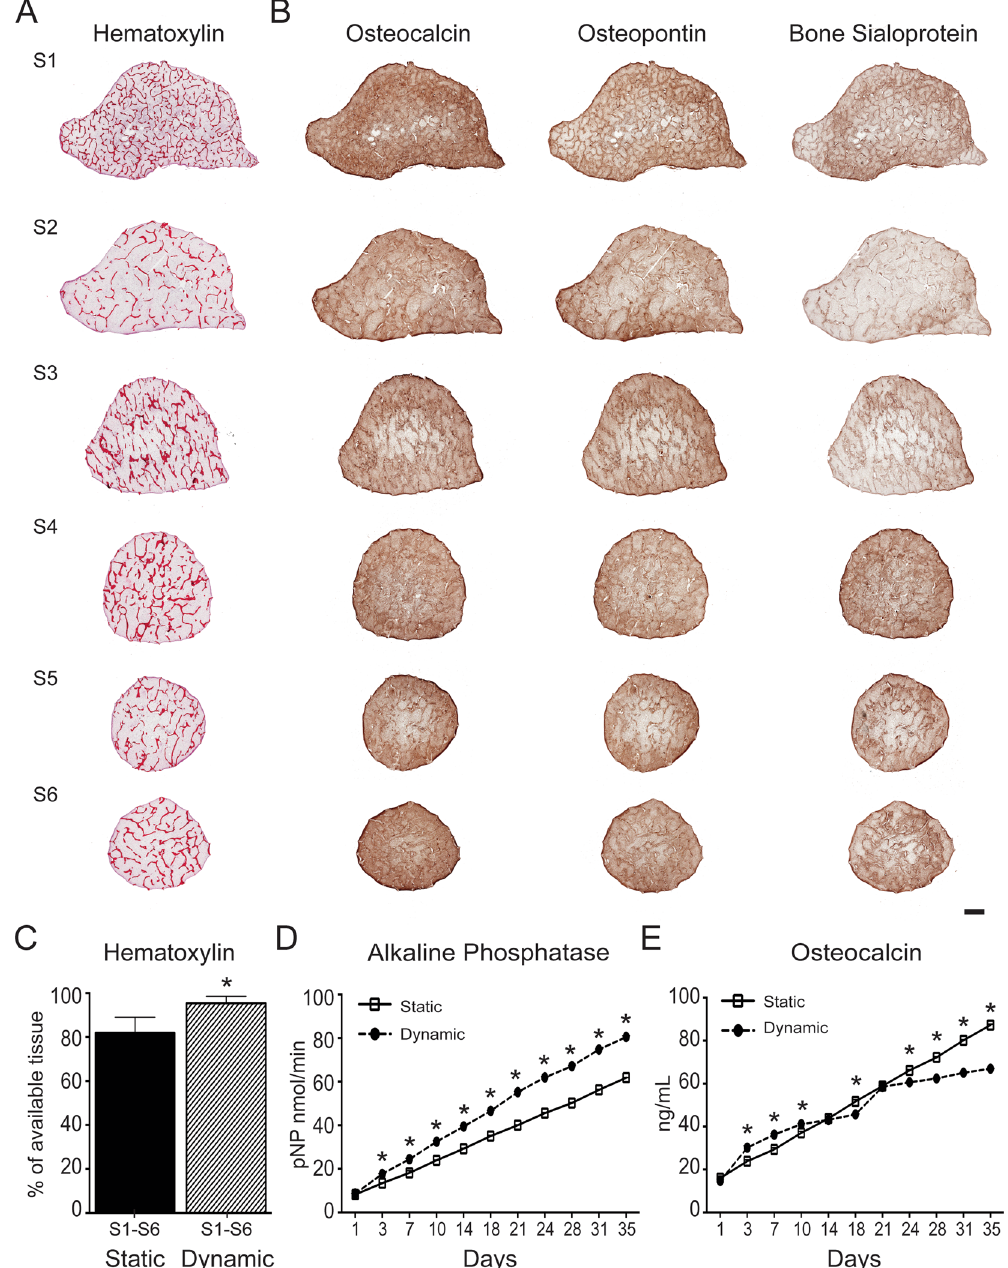
Figure 5. Tissue formation. ( A ) Histological analysis of samples corresponding to the six defect segments (S1-S6) cultured under dynamic conditions in bioreactors. Samples are stained with hematoxylin/eosin, which stains cell nuclei blue and extracellular matrix pink. Scale bar: 2 mm. ( B ) Immunohistochemical analysis of samples corresponding to the six defect segments (S1-S6) cultured under dynamic conditions in bioreactors. Samples stain positive (brown) for osteocalcin, osteopontin and bone sialoprotein. Scale: 2 mm. ( C ) Quantification of hematoxylin/eosin staining for samples corresponding to the six defect segments (S1-S6) cultured under static and dynamic conditions in bioreactors. Data represent averages ± SD (n = 18, Student’s t-test, P < 0.05; * denotes significant difference to static conditions). ( D ) Quantification of alkaline phosphatase and osteocalcin released from samples cultured under static and dynamic conditions in bioreactors. Data represent averages ± SD (n = 3, Student’s t-test, P < 0.05; * denotes significant difference to static conditions). Abbreviations: S, segment. Additional results are presented in Figs S10 and